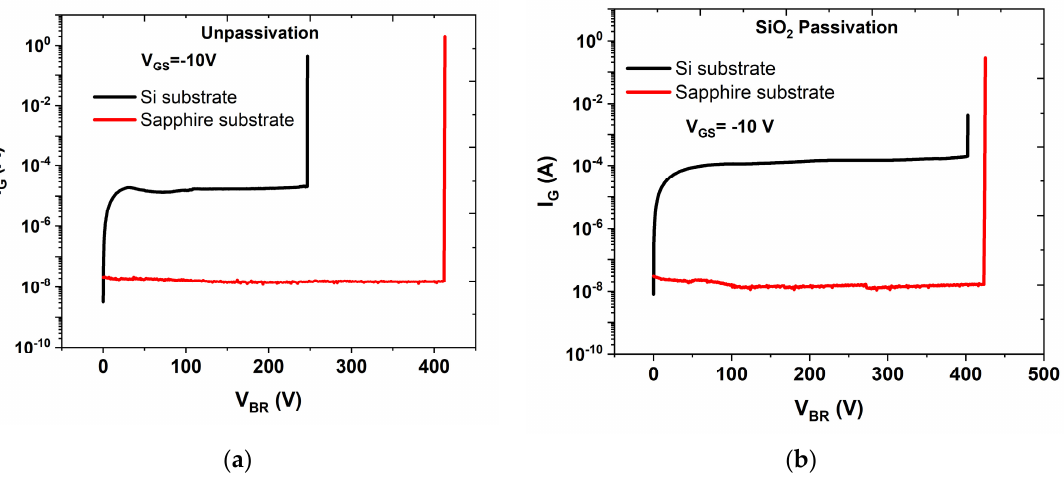
Figure 3. The off ‐ state I GS ‐ V DS curves of AlGaN/GaN HEMTs on Si and sapphire substrates ( a ) with ‐ out and ( b ) with SiO 2 passivation.